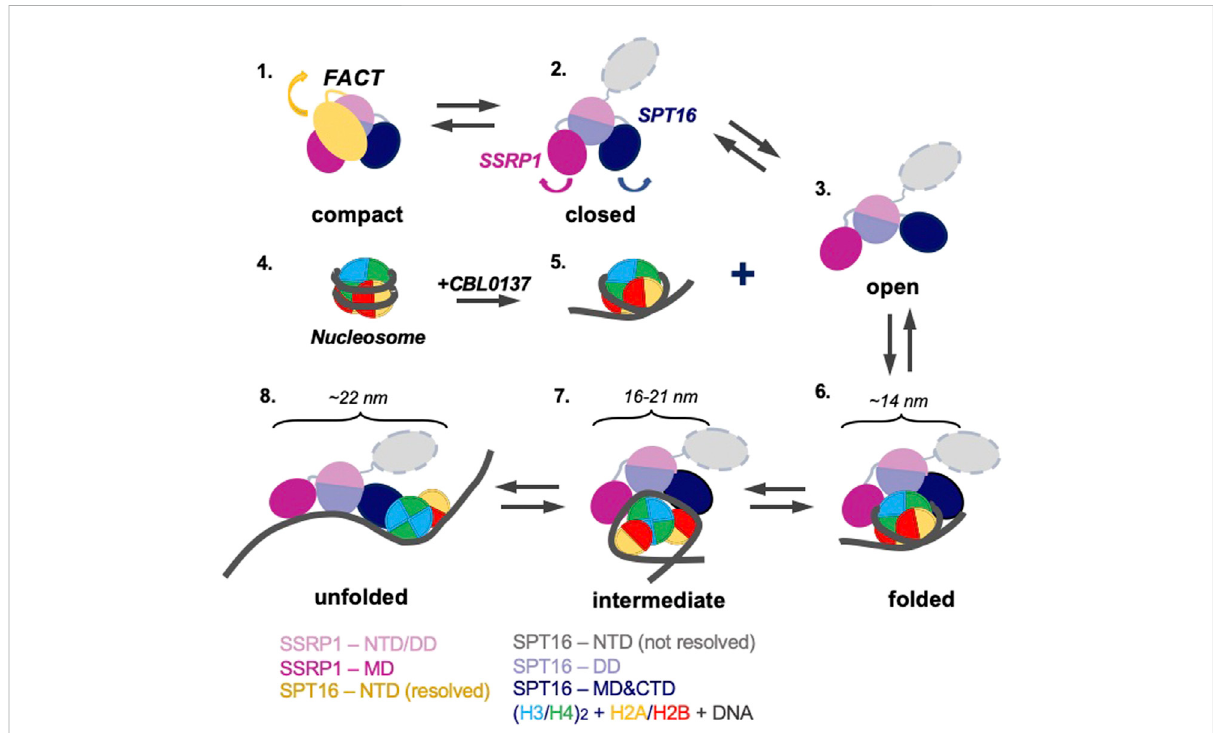
Model of nucleosome unfolding by FACT in the presence of curaxin CBL0137. FACT is a mixture of compact, closed and open states (intermediates 1, 2, and 3). As nucleosomal DNA is partially uncoiled from the histone octamer in the presence of CBL0137 (intermediates 4 and 5), FACT-binding sites on the surface of H2A/H2B dimers become available for interaction with FACT, and the folded complex is formed (intermediate 6). As a result, FACT induces further nucleosome unfolding (intermediates 7 and 8). The linear dimensions of the intermediates 6 and 7 are indicated. The color code is shown at the